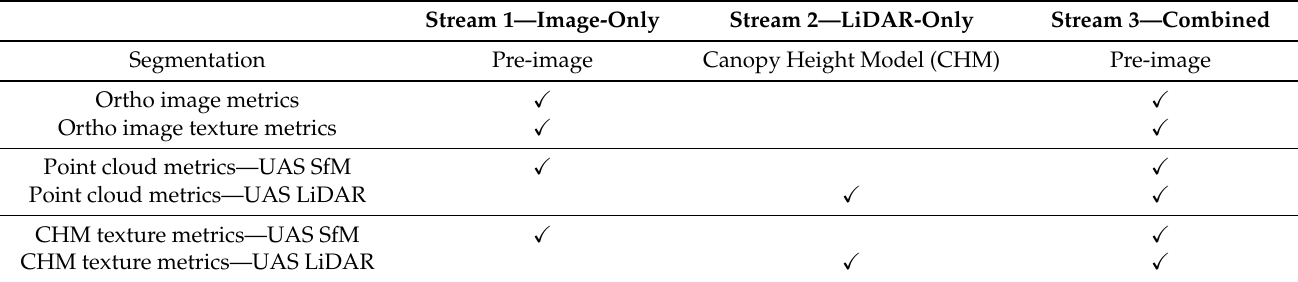
Table 3. Segmentation description and metric sources for each of the three processing data